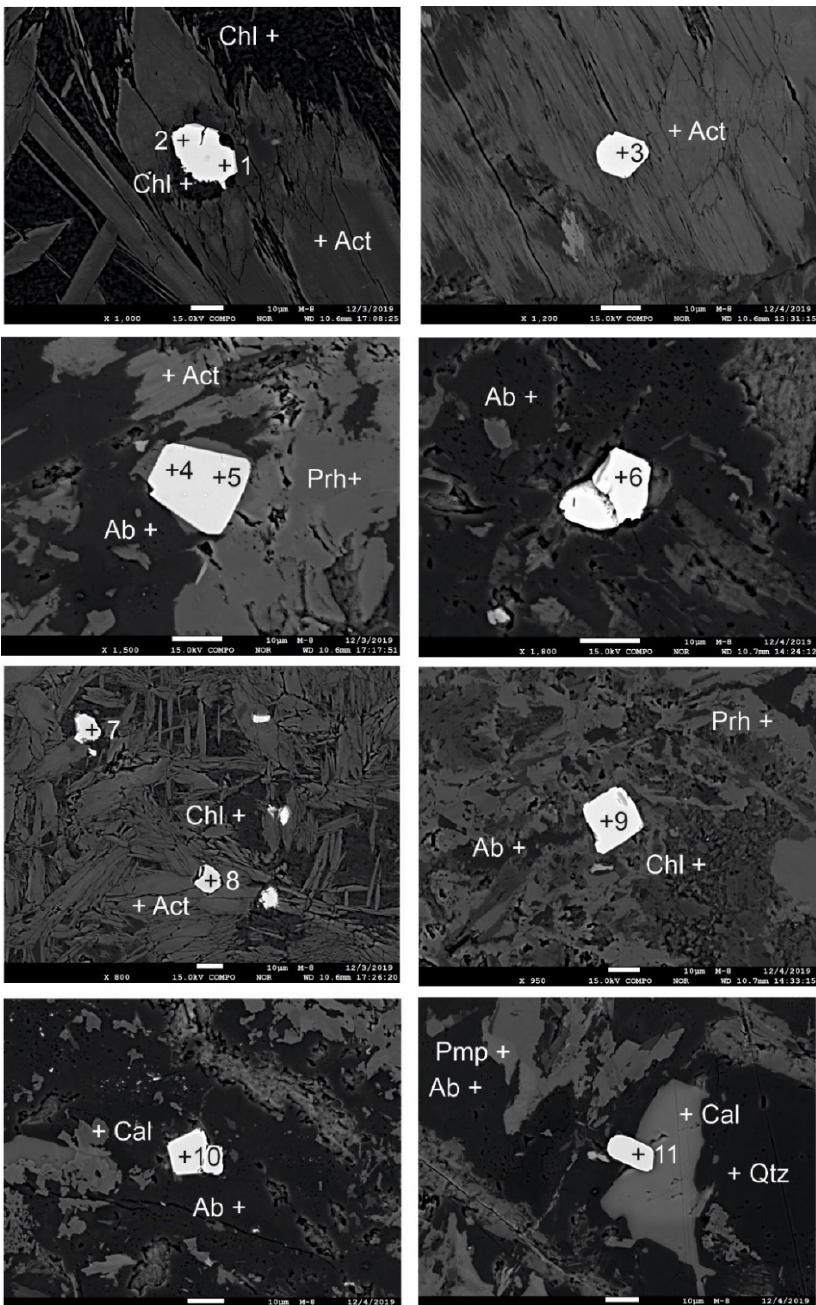
Figure 7. Back scattered electron (BSE) images of basalts from Malužiná; Act = actinolite, Chl = chlorite, Ab = albite, Prh = prehnite, Pmp = pumpellyite, Cal = calcite, Spl = spinels; the numbers in figures correspond to those in Tables 2–5. Table 6. Selected analyses of spinels.